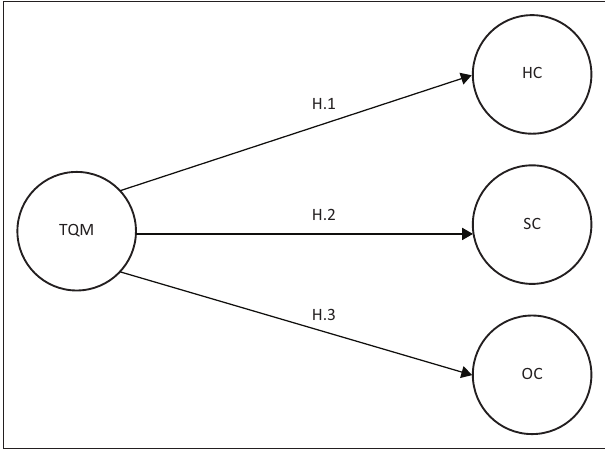
FIGURE 1: A model of the relationship between Total Quality Management and intellectual capital. TQM, total quality management; HC, human capital; SC, social capital; OC, organisational